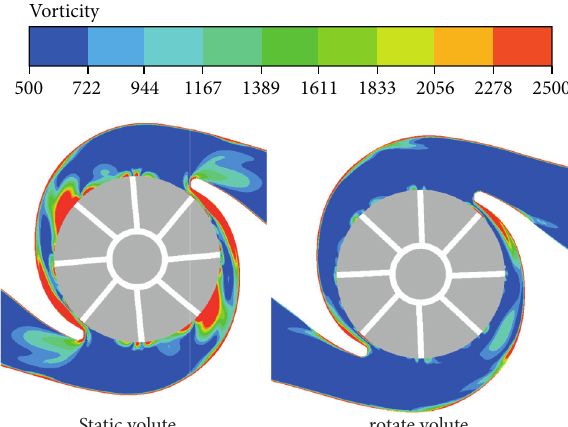
Figure 16: Comparison of vorticity contours among rotate and static volute.